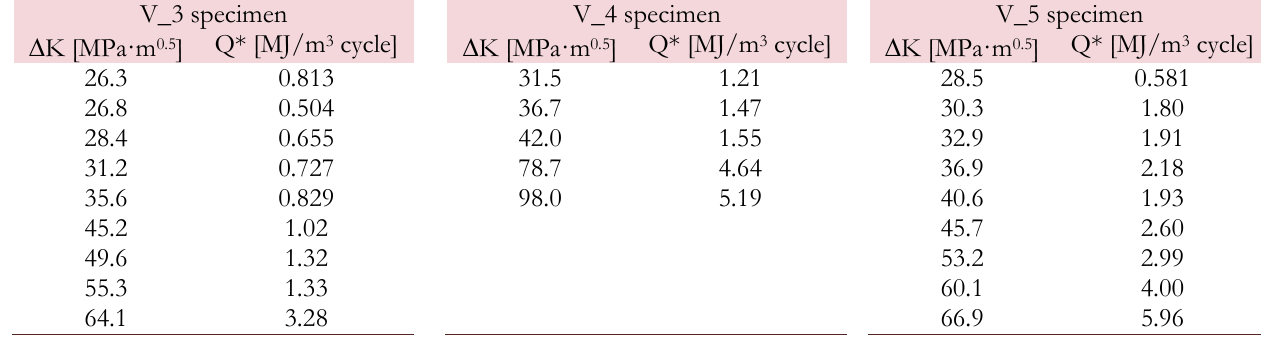
Table 1: Q* values calculated for different specimens at different  K